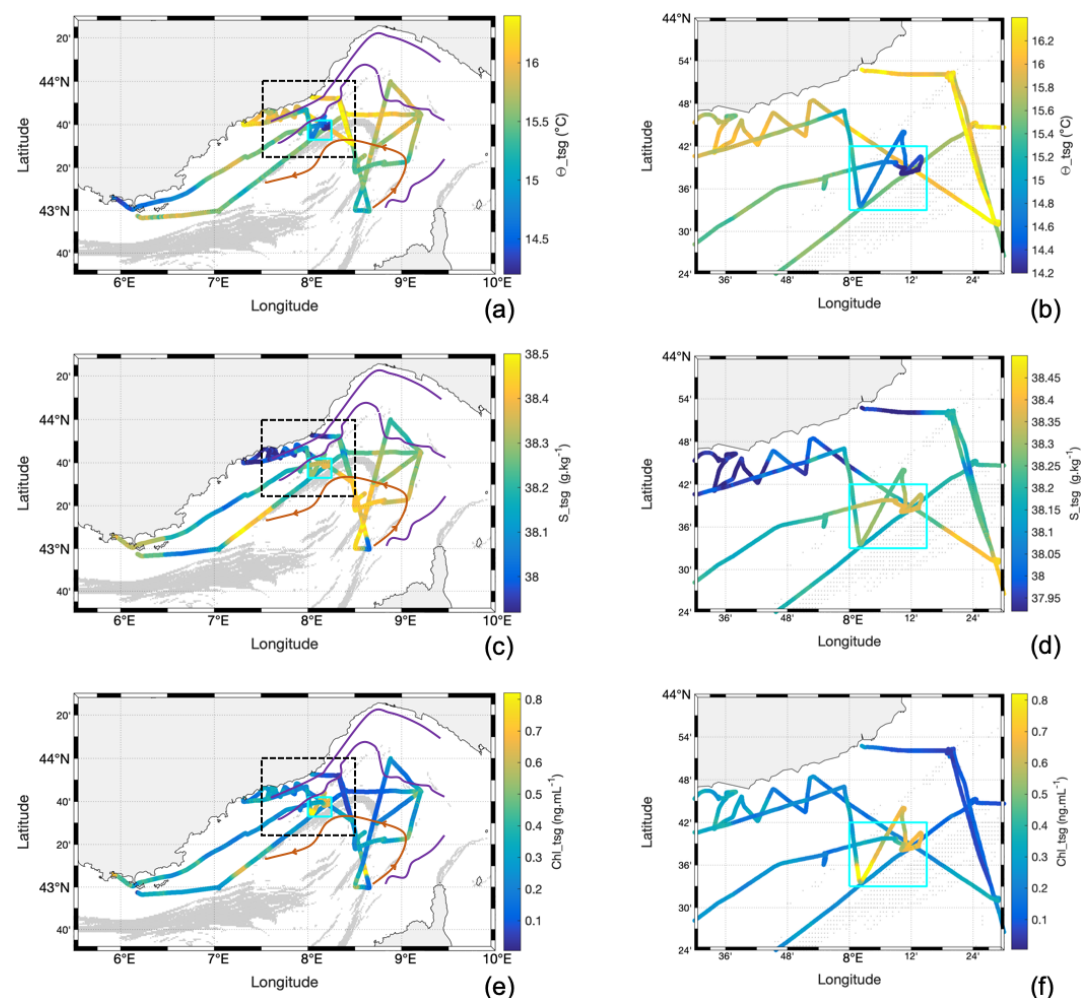
Figure 5. Water surface characteristics from TSG along the cruise, superimposed with FSLEs calculated from altimetry showing the (a,b) (cid:50) _tsg, (c,d) S_tsg, and (e,f) Chl_tsg concentration. Panels (a) , (c) , and (e) show the whole geographic region of the cruise, and panels (b) , (d) , and (f) illustrate the respective zoom of the indicated region (shown in the black dotted square in the corresponding left panel), identifying the particular TSG region of interest (cyan square) sampled 1d after the storm.